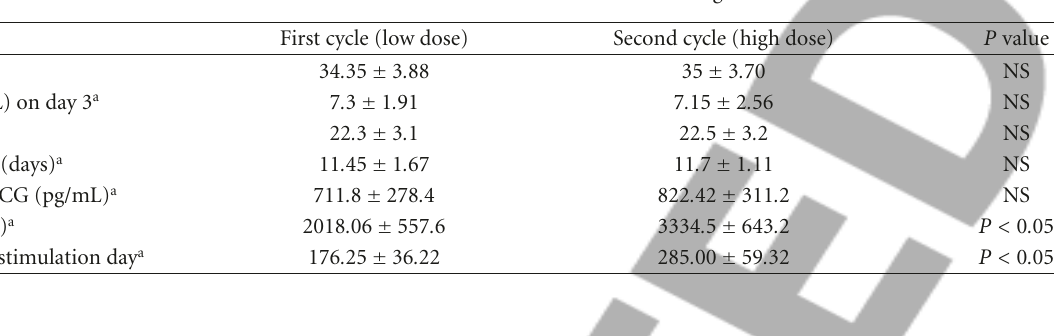
Table 1: Baseline information on the characteristics of women and